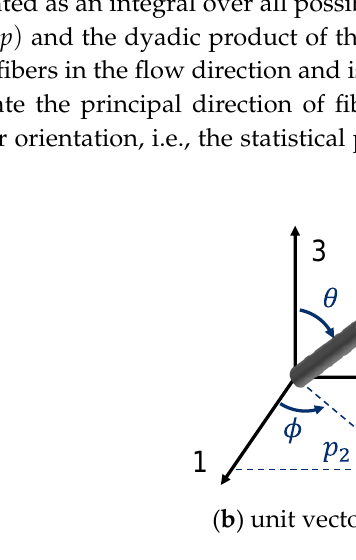
Figure 7. Tensorial Description of the Fiber Orientation